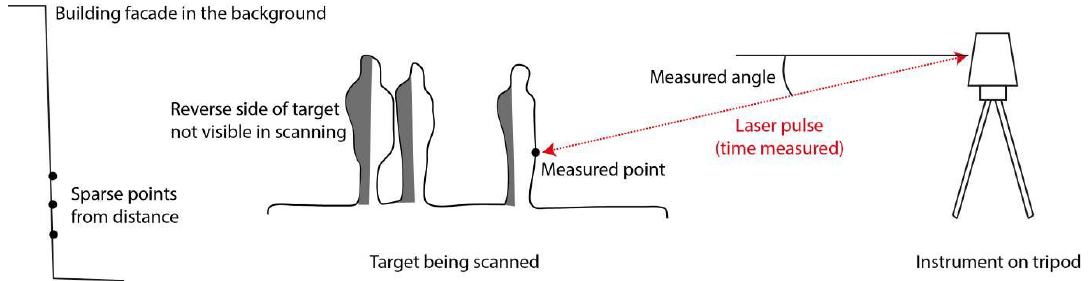
Figure 2. The operating principle of Terrestrial Laser